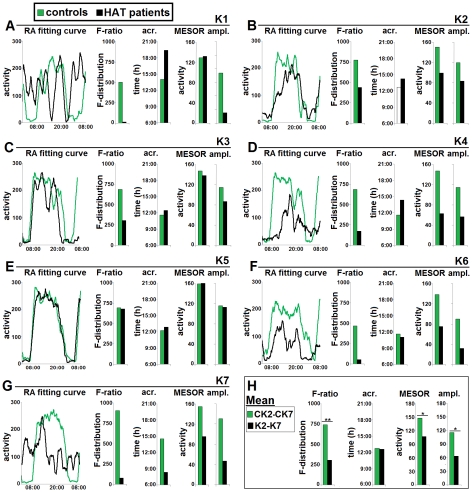
Characteristics of the rest-activity rhythm in DRC patients.The characteristics of the rest-activity (RA) rhythm in patients K1–K7 and control subjects (A–F) are shown together with the assessment of statistical difference between adult control subjects and patients (H). A–F. All the parameters have been evaluated as explained in the legend to Figure 4. Note the different degrees of alterations of the waveform (RA fitting curve), of the F-ratio, acrophase (acr.), MESOR, and amplitude (ampl.). H: the statistical evaluation shows significant intergroup differences of the F-ratio, acrophase, MESOR and amplitude; *P<0.05, **P<0.01, Student's unpaired t test. Fcrit = 3.68. For RA rhythms of all patients, F-ratio>Fcrit; P<0.000001.